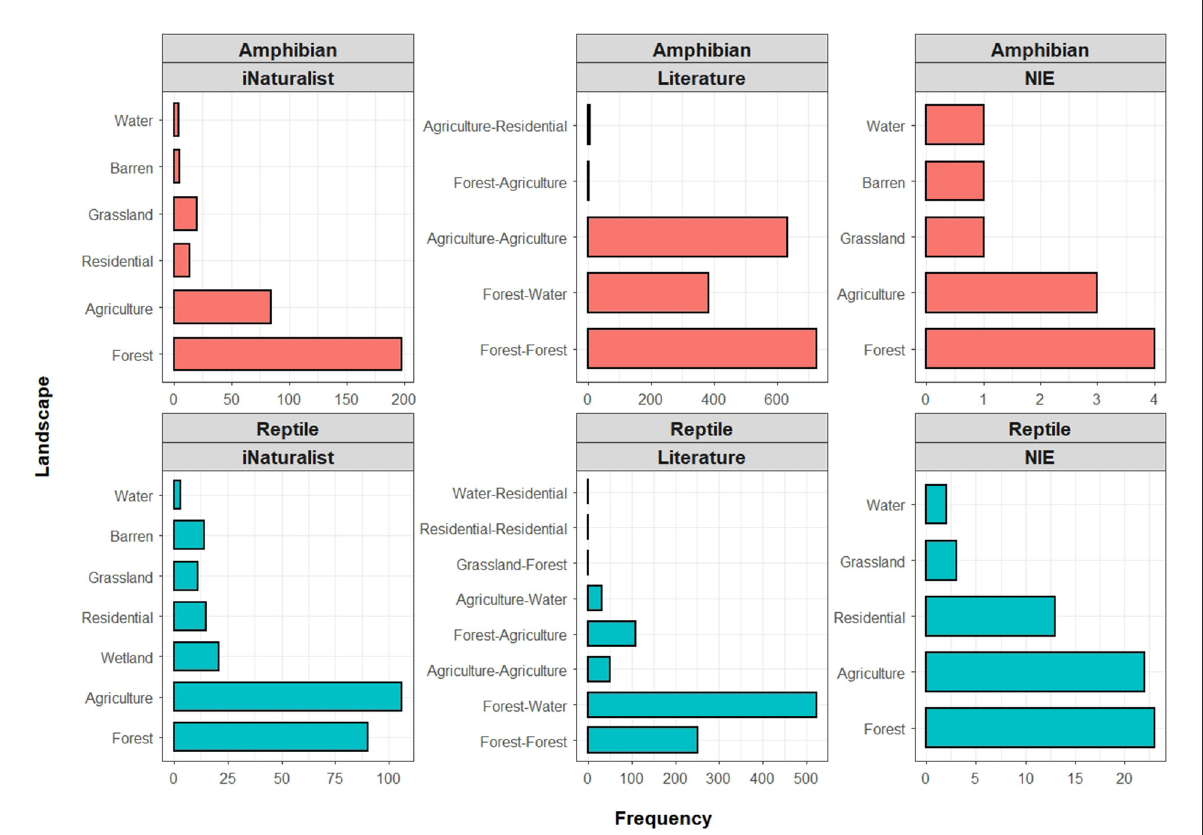
FIGURE10 Distribution of roadkill records across different habitat types compared among the iNaturalist, literature, and governmental (National Institute of Ecology; NIE) data. While the specific classification of habitat types differ between datasets, all three datasets generally converge on a congruent pattern by detecting the highest frequency of herpetofauna roadkills in either forest or agricultural